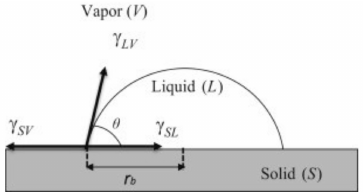
Figure 1. Static contact angle measurement with the sessile drop